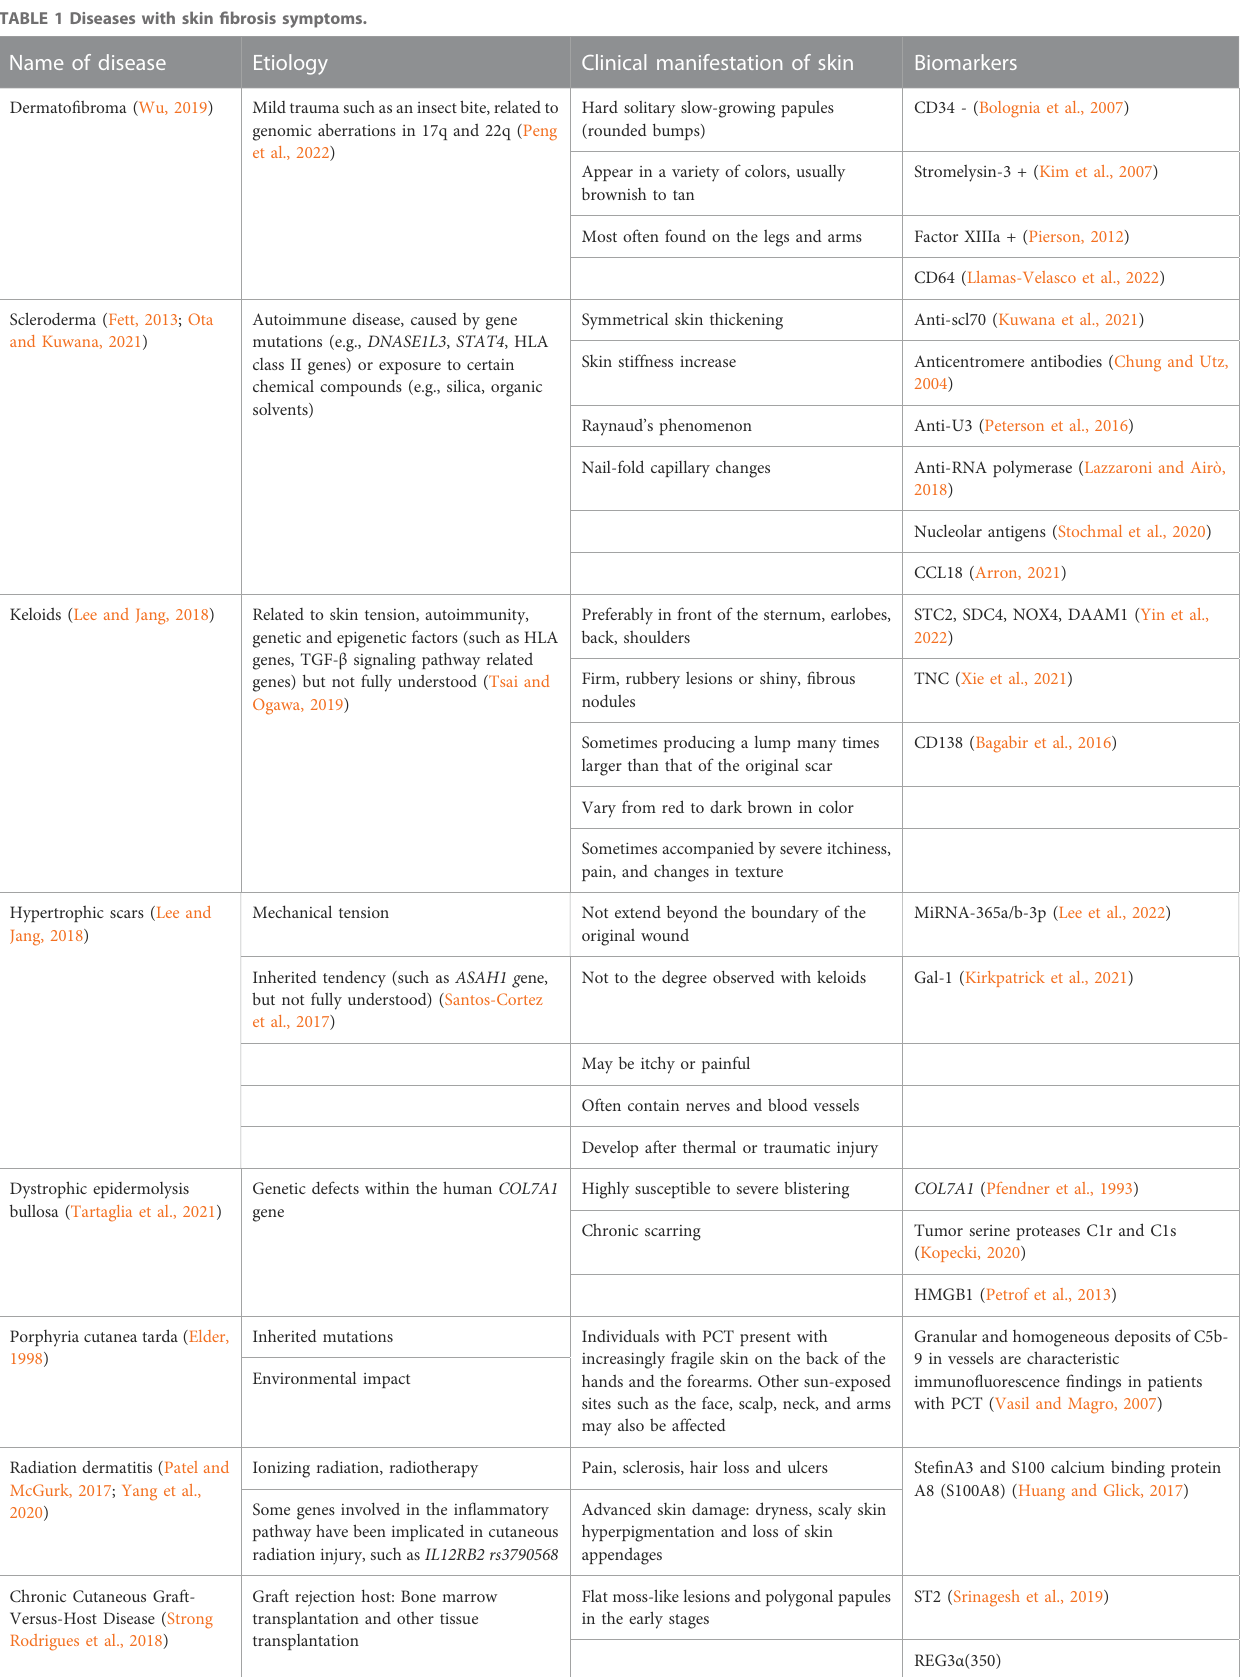
TABLE 1 Diseases with skin fi brosis